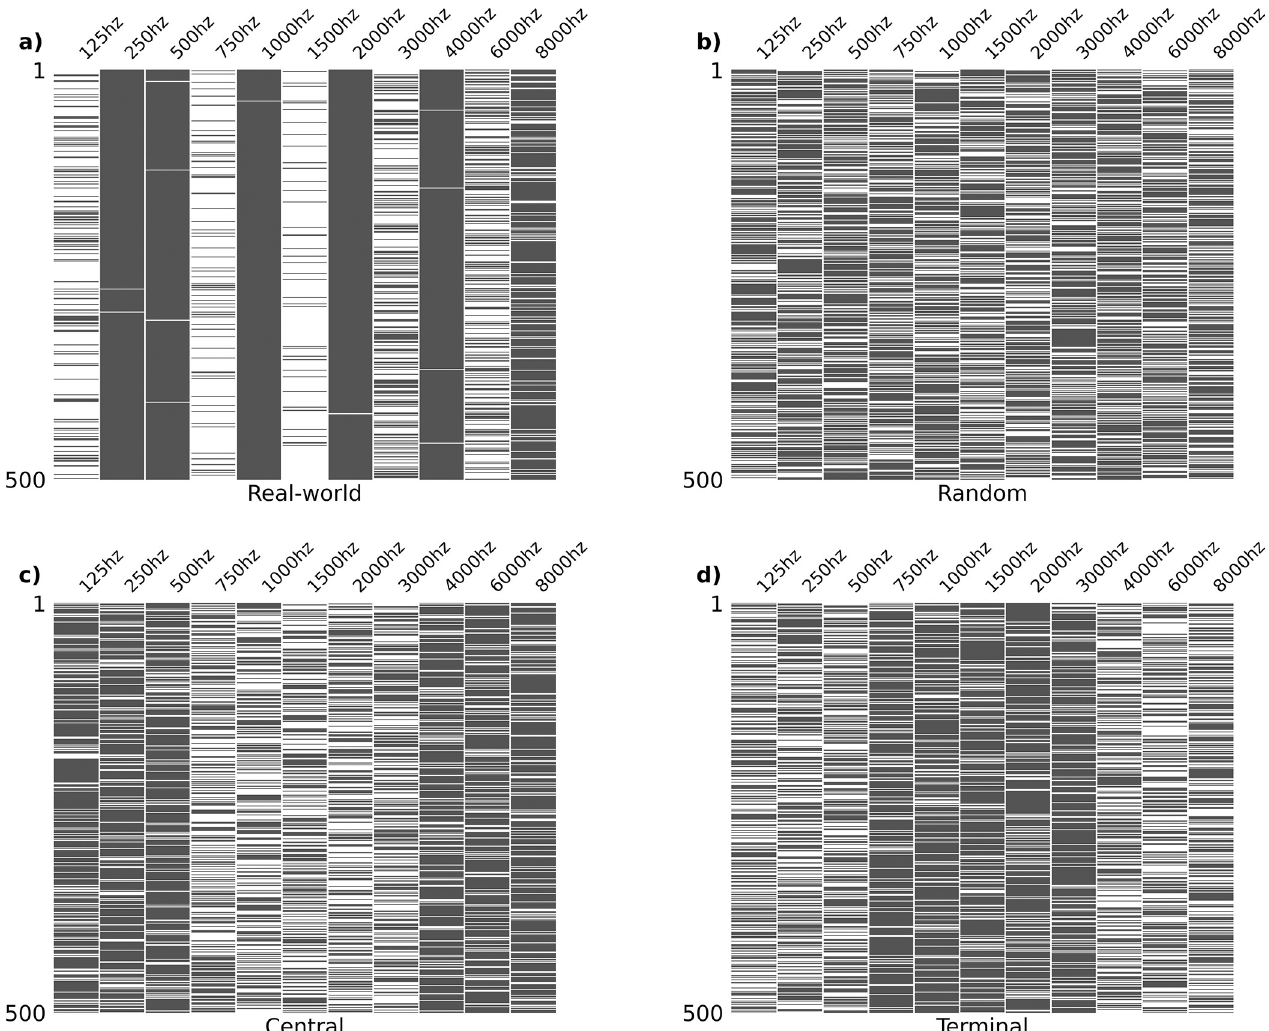
Fig 3. Visualization of sparsity distribution. All tested sparsity distributions applied to sample dataset of 500 audiograms. Quantity of sparsity fixed at 3 missing features per instance. Rows represent audiograms, columns represent features. Black bars indicate present data, white bars indicate missing data. (a) Real-world distribution sets weighted likelihood for feature removal equivalent to the corresponding parent subset. (b) Random distribution sets equivalent likelihood of removal for all features. (c) Terminal distribution is weighted 3-fold towards removing the terminal 6 frequencies (125 Hz, 250 Hz, 500 Hz, 4000 Hz, 6000 Hz, 8000 Hz). (d) Central distribution is weighted 3-fold towards removing the central 5 frequencies (750 Hz, 1000 Hz, 1500 Hz, 2000 Hz, 3000 Hz).